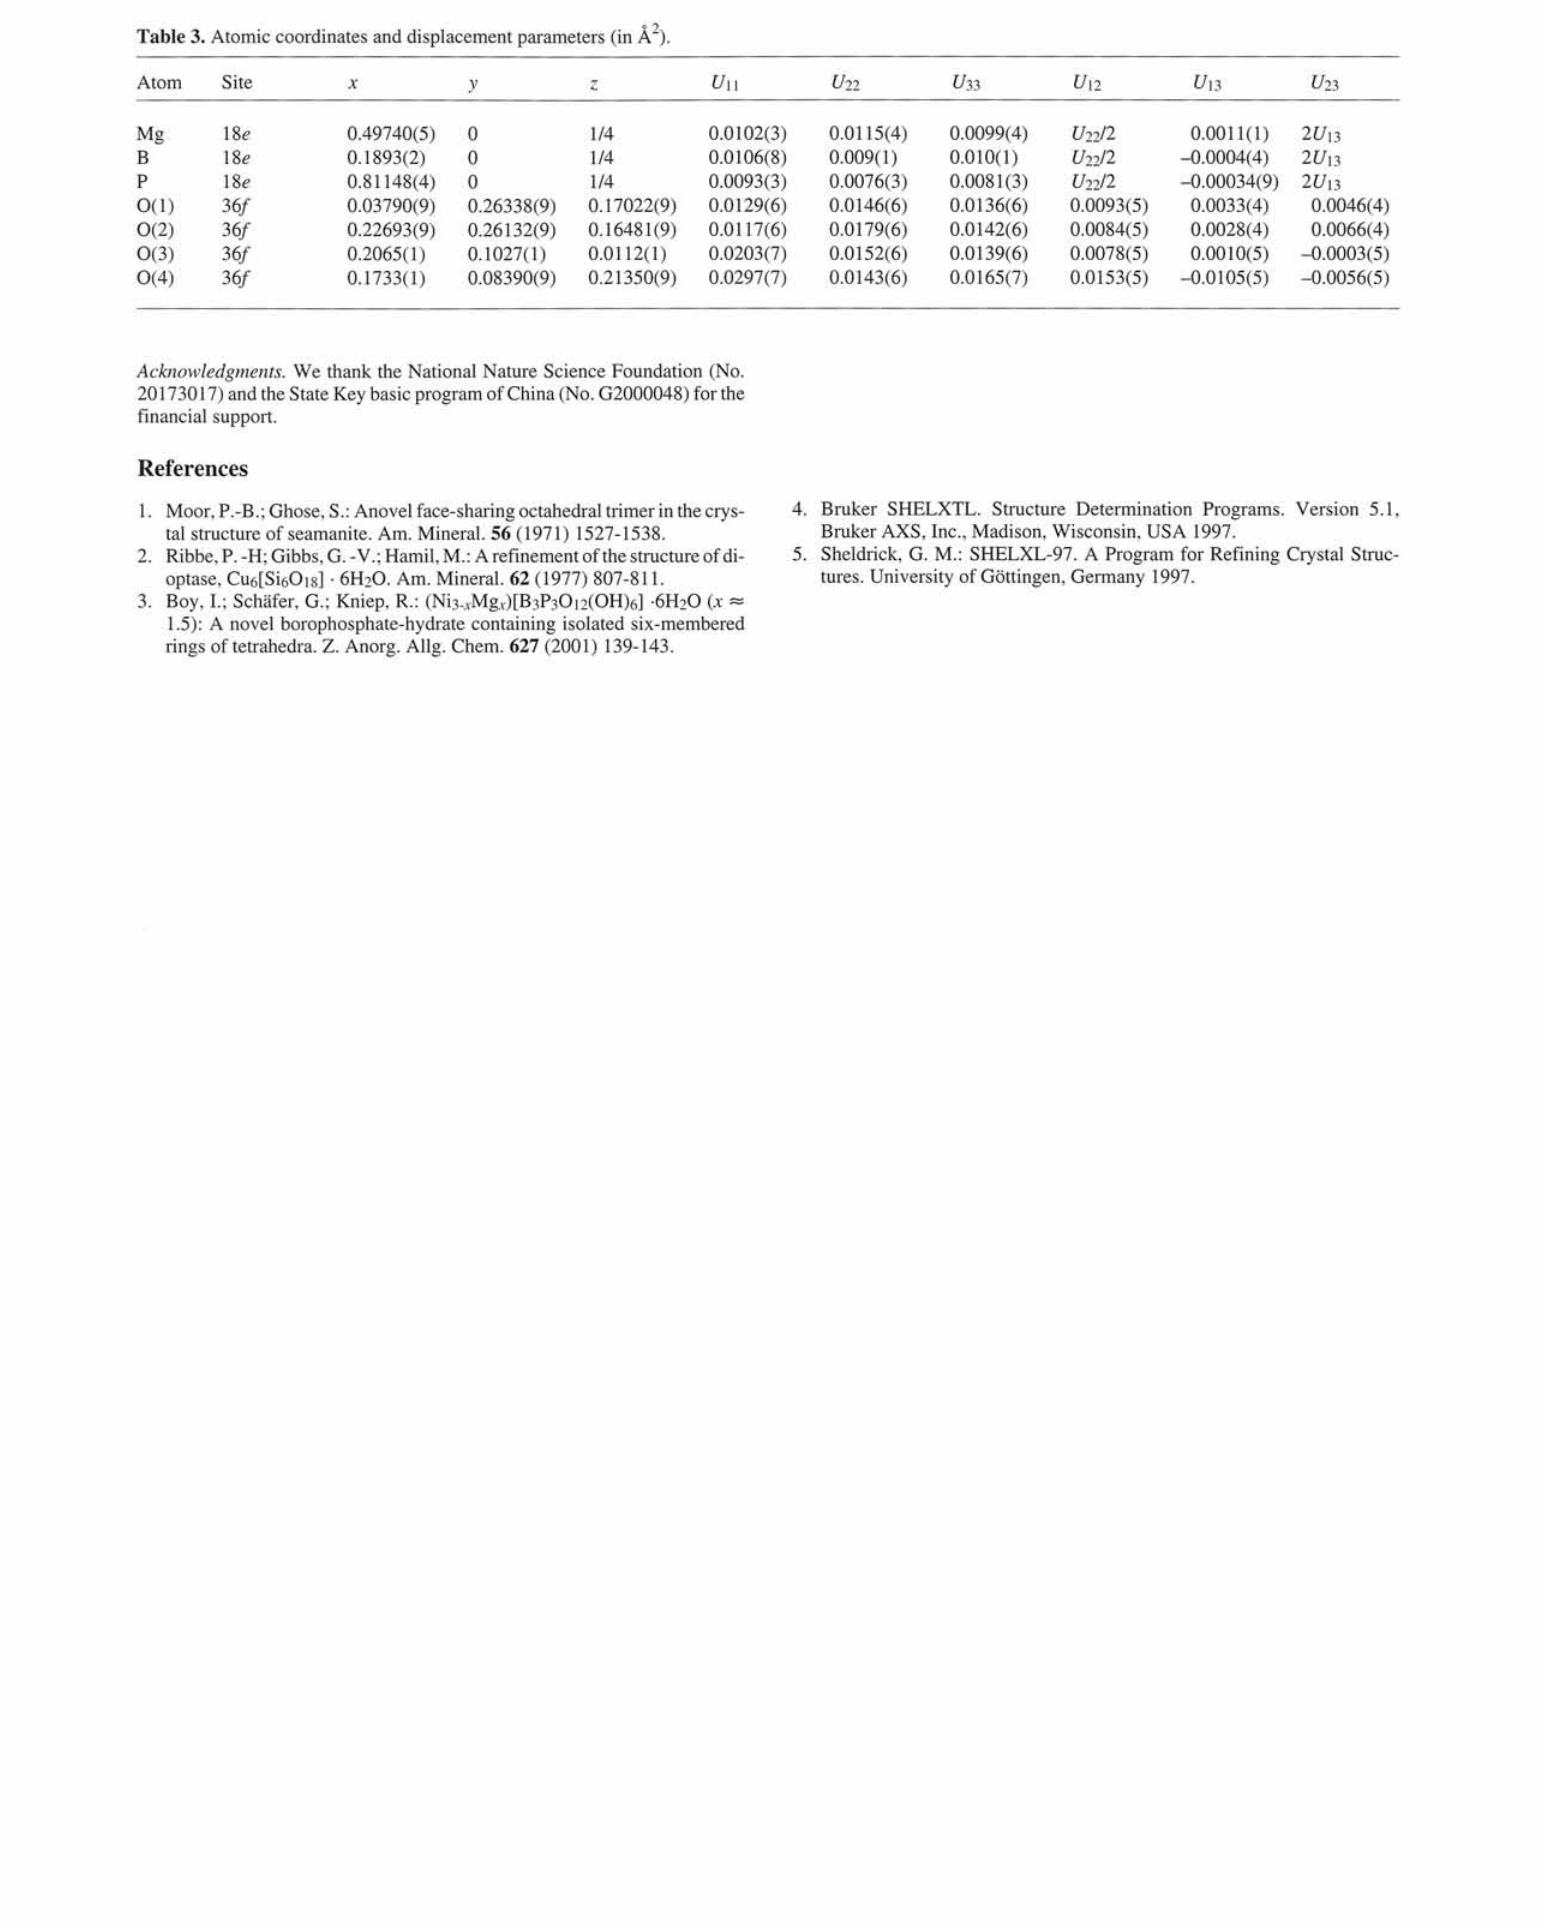
Table 3. Atomic coordinates and displacement parameters (in Á 2